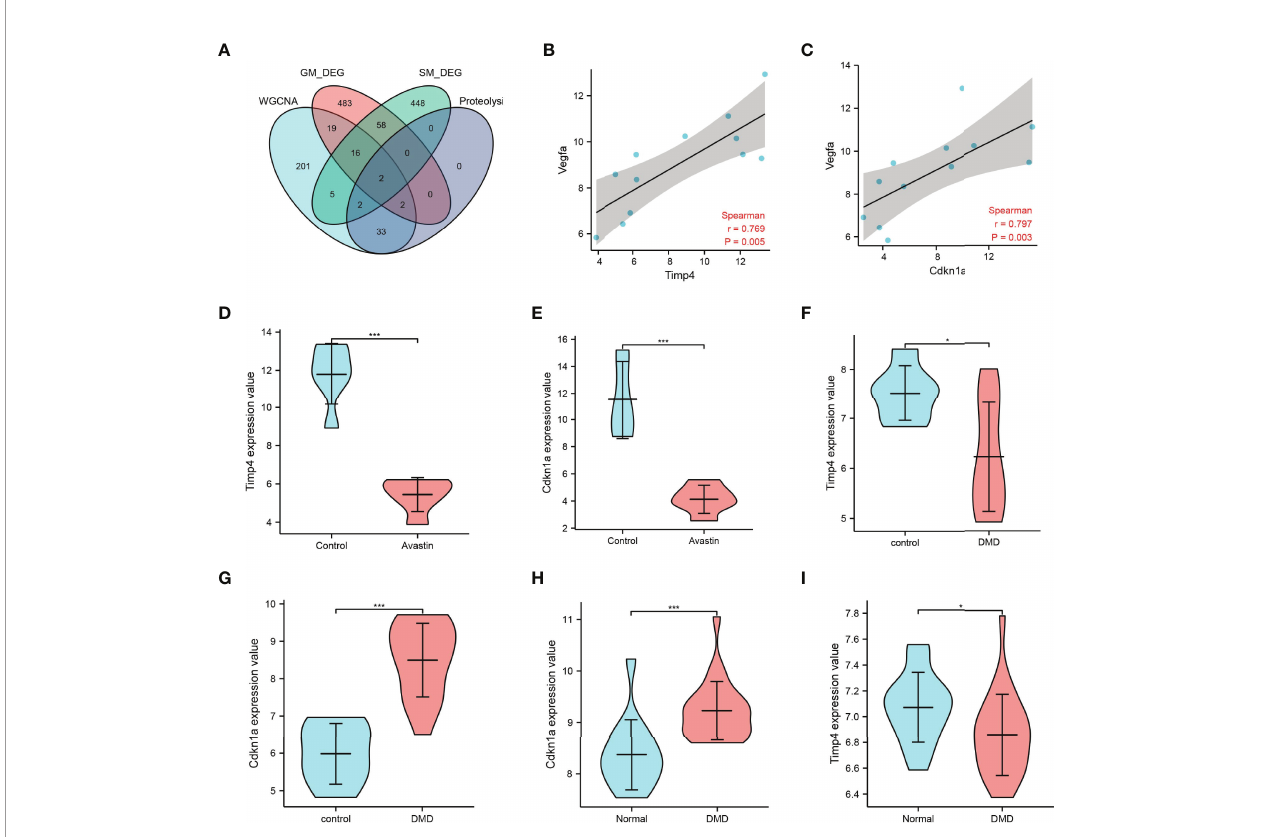
FIGURE 5 | Map3k6 expression. (A) Venn map showing the intersection of different datasets; correlation of (B) Timp4 and (C) Cdkn1a with Vegfa; (D) Timp4 and (E) Cdkn1a expression in drug-treated and control groups; (F) Timp4 and (G) Cdkn1a expression in different groups in GSE38417; (H) Timp4 and (I) Cdkn1a expression in different groups in GSE6011. *p < 0.05,***p <